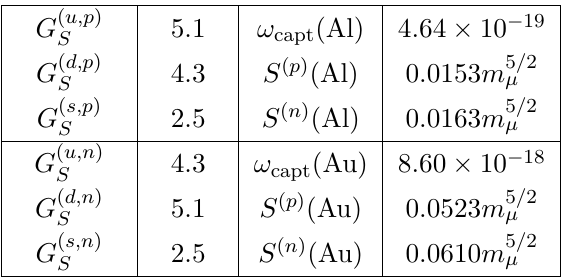
Table 3 . The numerical results used for calculation of µ – e conversion